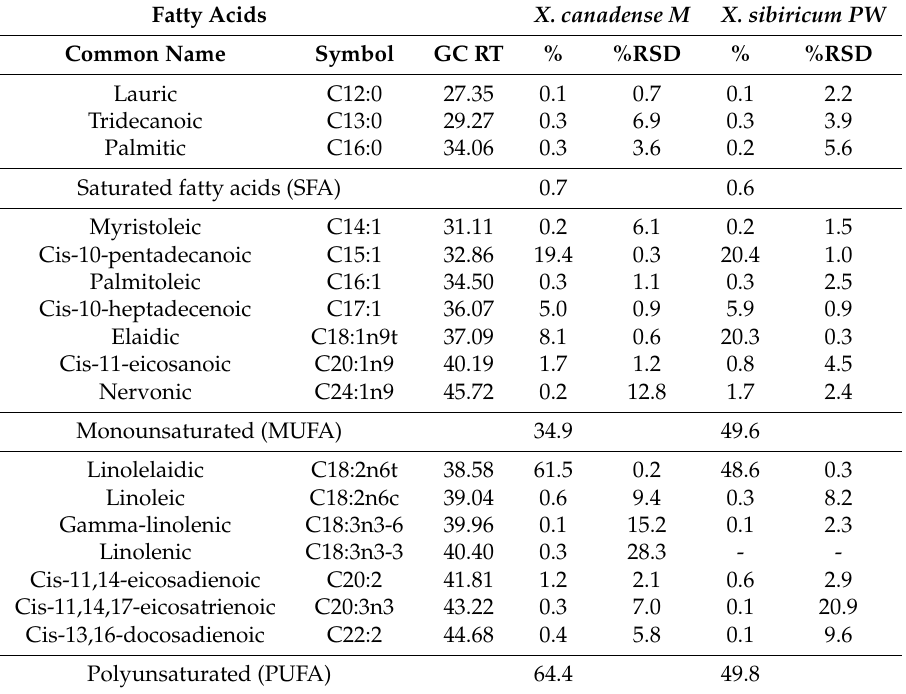
Table 2. Comparison of relative contents of fatty acids between X. canadense M and X. sibiricum PW. Fatty Acids X. canadense